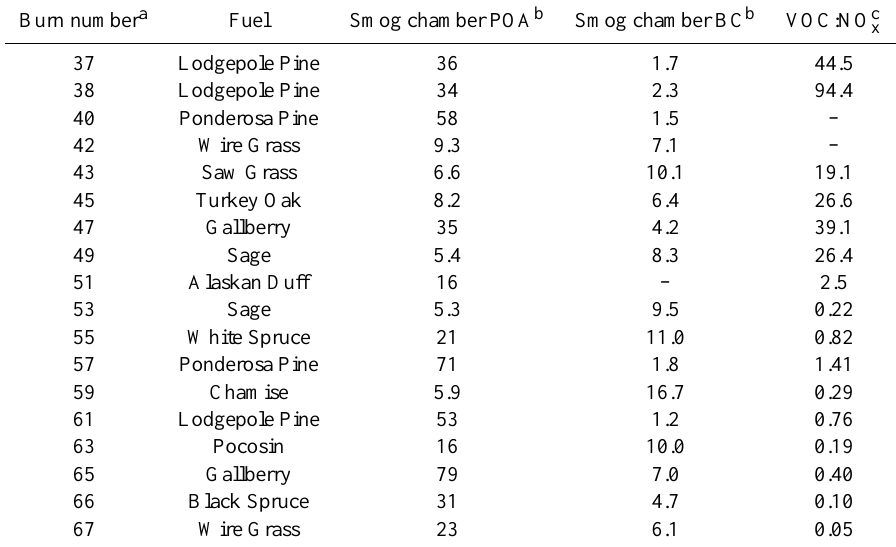
Table 2. Data from aging experiments. Blank entries indicates data not available.